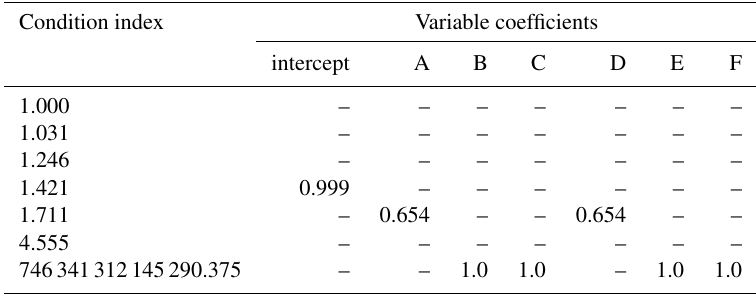
Table 1. Example of the table showing the output of the multicollinearity test generated by LAND-SVA.